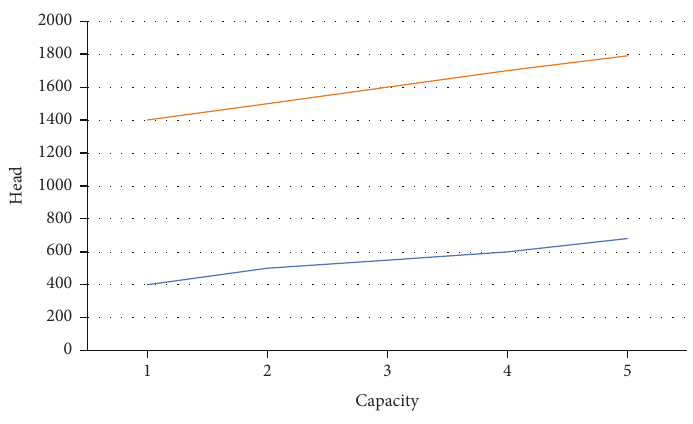
Figure 4: Valve e ffi ciency curve.